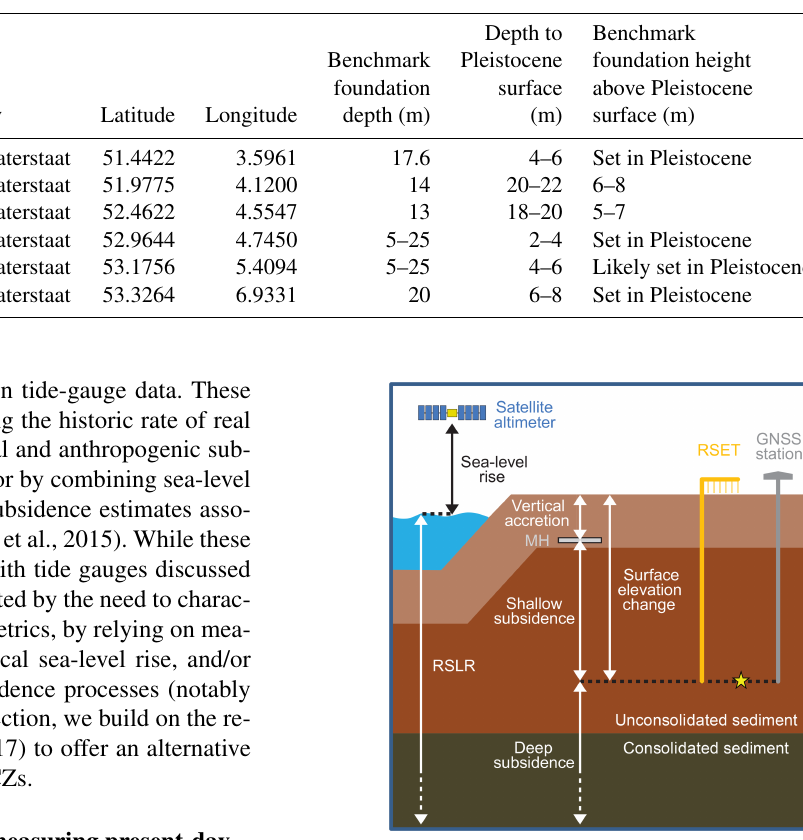
Figure 5. Schematic of combined instrumentation that includes an RSET-MH, which measures shallow subsidence, and a GNSS sta- tion, which measures deep subsidence. To measure shallow subsi- dence using an RSET-MH, surface elevation change is subtracted from vertical accretion (Cahoon, 2015). Surface elevation change is the change in height from a horizontal arm at a fixed elevation to the wetland surface measured using vertical pins. Vertical accretion is the thickness of sediment that accumulates above a feldspar marker horizon. If constructed with similar foundation depths (as shown by the star), the RSET-MH and GNSS station collect data that are com- plementary and can be added together and combined with satellite altimetry data to calculate the rate of